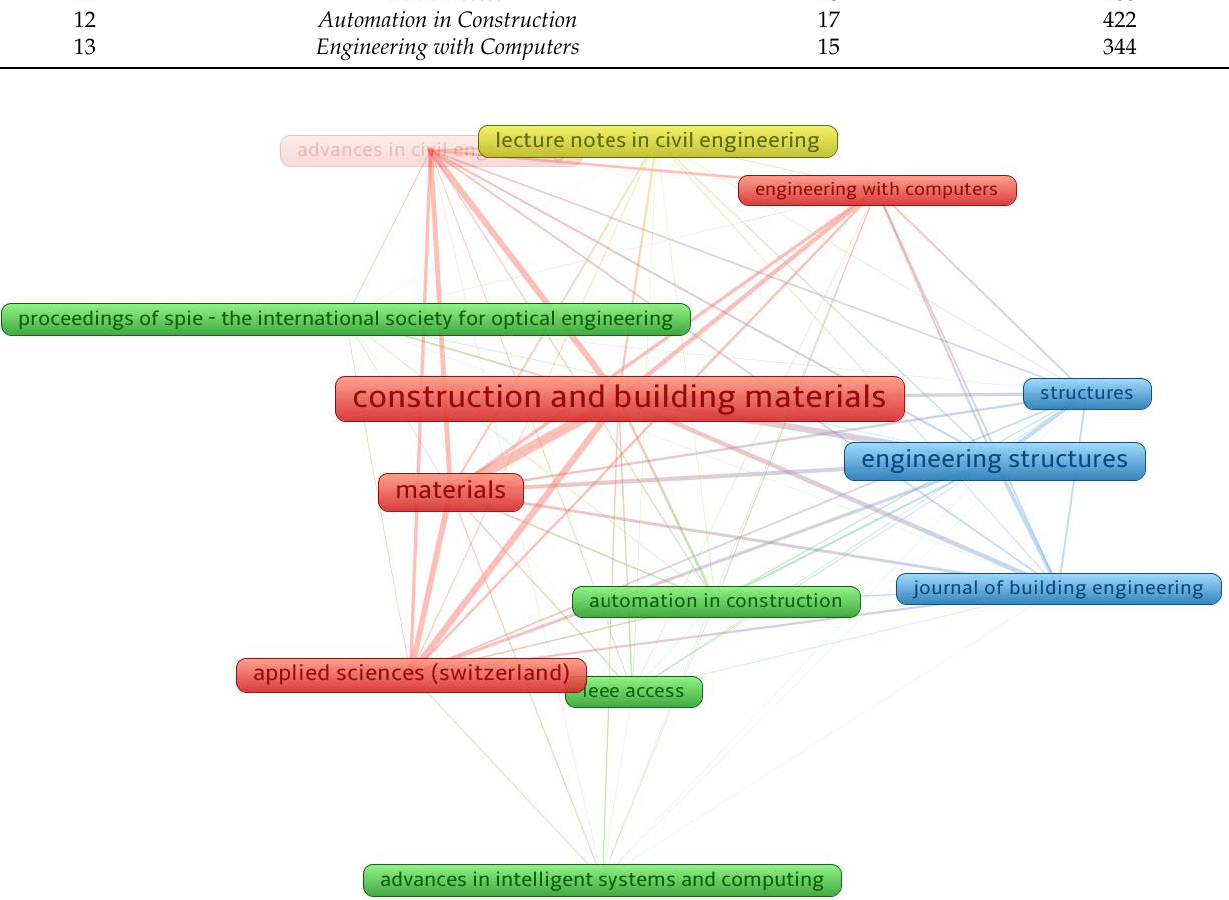
Figure 6. Systematic map of journals that published a minimum of 10 documents.